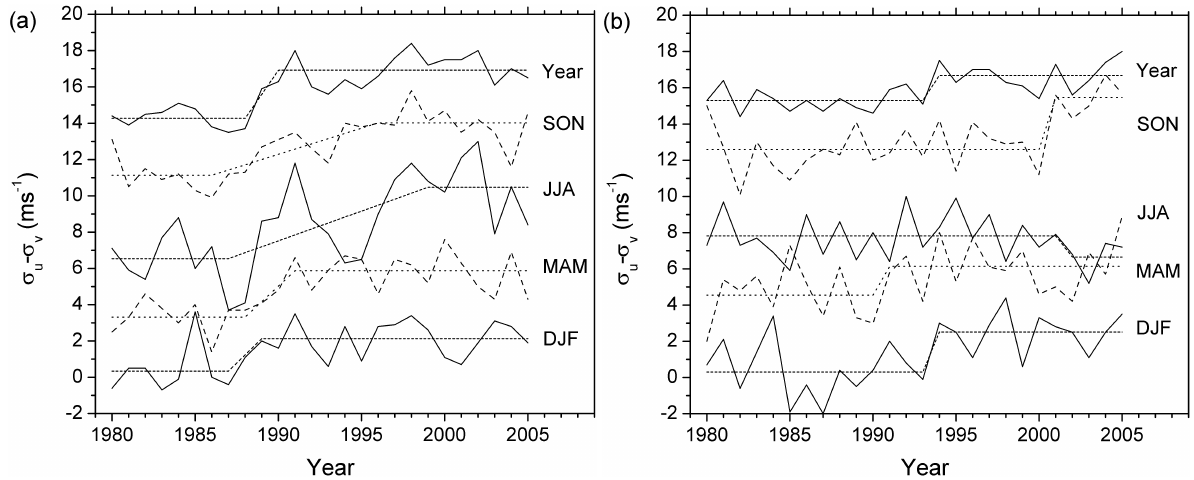
Fig. 8. Seasonal mean differences of zonal-meridional standard deviation 1σ = σ u − σ v of filtered MLT winds (a) 2–7 days window, (b) 7–30 days window. The time series have been shifted with respect to each other by adding 3ms − 1 (MAM), 6ms − 1 (JJA), 11ms − 1 (SON) and 14ms − 1 (annual mean). Results of a ramp function regression after Mudelsee (2000) are added.